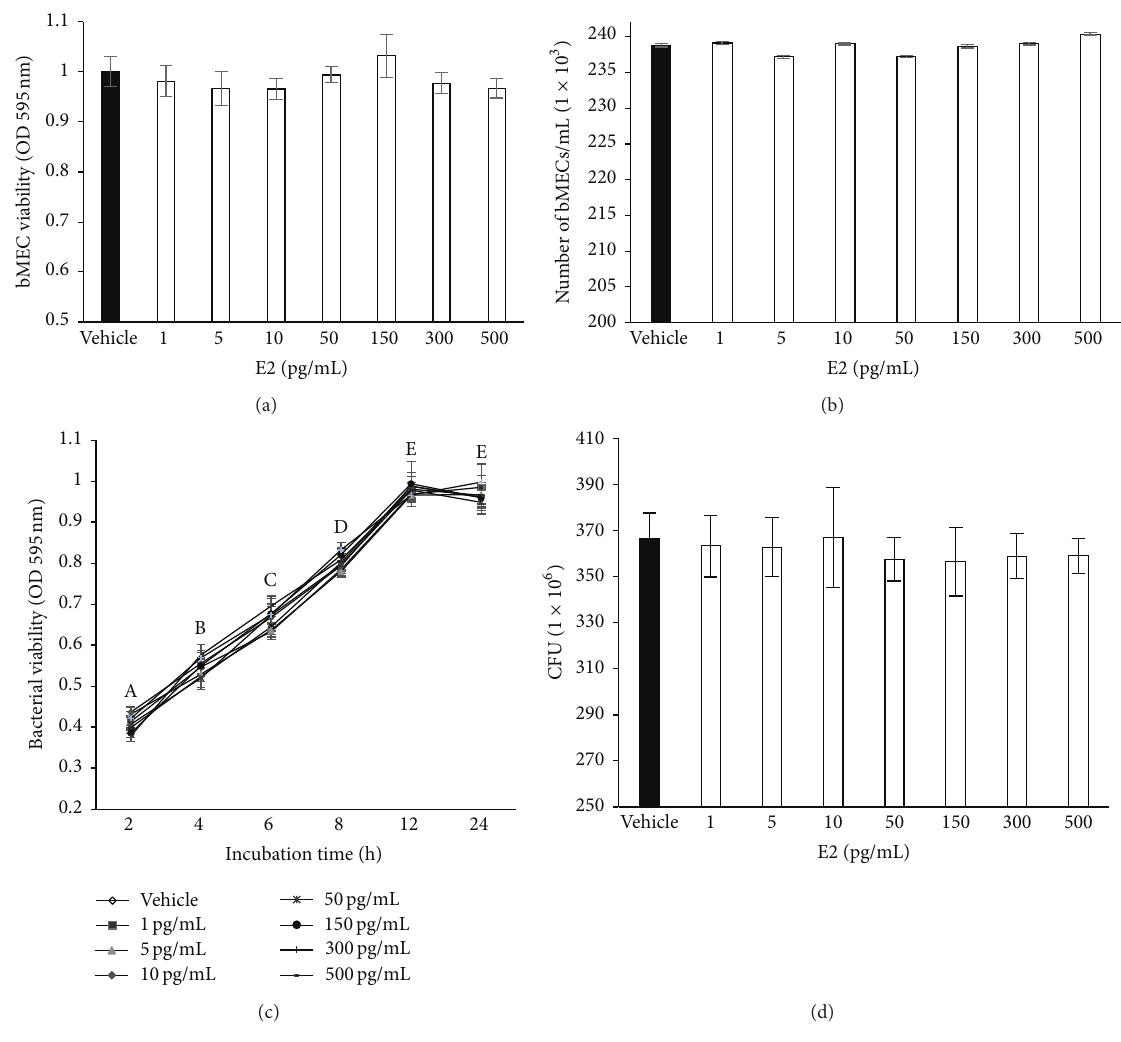
Figure 1: Bovine mammary epithelial cell viability and S. aureus growth in the presence of E2. (a) bMECs were cultured with E2 and viability was determined by MTT assay at 24 h. (b) bMECs were cultured with the hormone and viability was calculated by a trypan blue exclusion assay. The number of viable bMECs/mL is shown. In all cases, concentrations evaluated were 1, 5, 10, 50, 150, 300, and 500 pg/mL. (c) S. aureus was cultured in the presence of E2 at different times during 24h and bacteria viability was analyzed by MTT assay. (d) Bacterial growth was determined counting the CFUs of S. aureus treated with different concentrations of E2 during 24 h. Each point in (a), (b), (c), and (d) shows the mean of triplicates ± SE of three independent experiments. The vehicle corresponds to bMECs treated with 1% ethanol. Different letters indicate significant changes among the different incubation times ( 𝑃 < 0.05